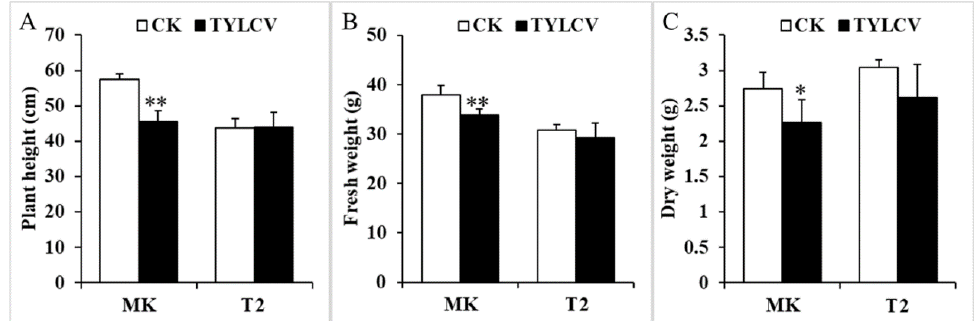
Figure 1. Plant height and biomass differences between the MK (S) and T2 (R) genotypes under TYLCV treatment. ( A – C ) the plant height ( A ), fresh weight ( B ), and dry weight ( C ) of MK and T2 infected by TYLCV for 26 d. The data represent the mean ± SD ( n = 3). Data were analyzed by an ANOVA in the SPSS software. * ( p < 0.05) and ** ( p < 0.01) indicate statistically significant differences.